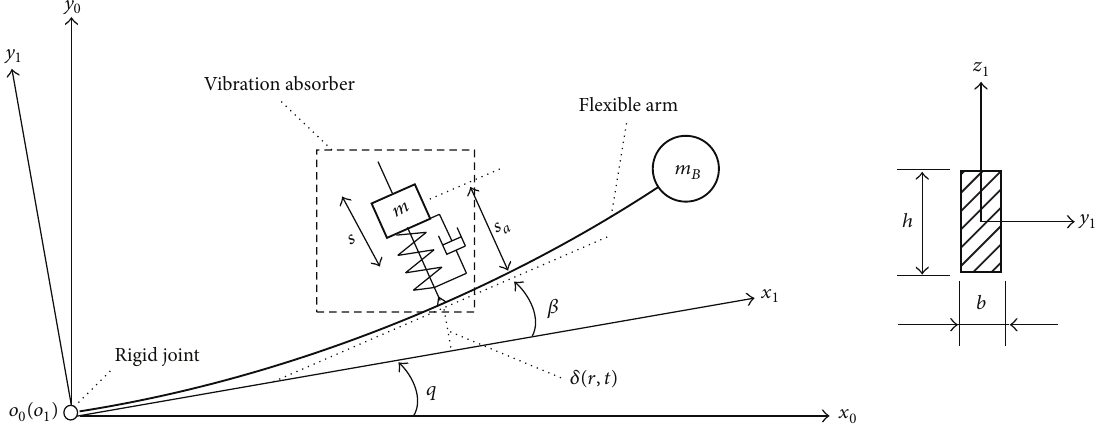
Figure 1: Model of the flexible arm with a vibration